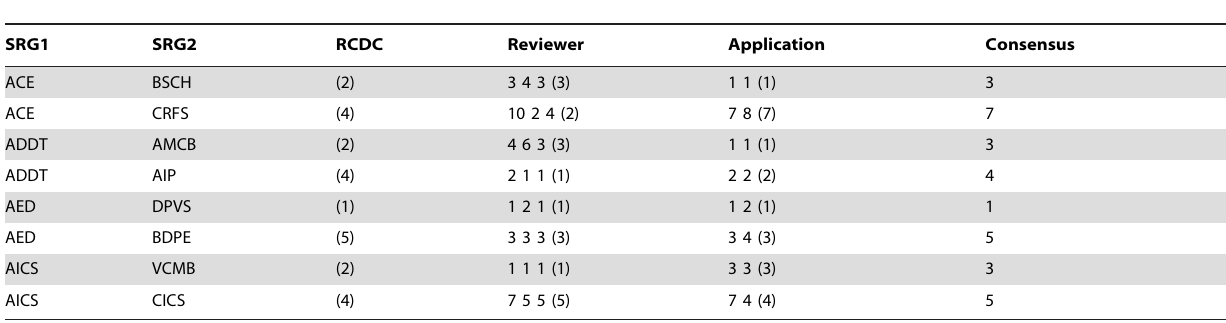
Table 2. Examples of consensus rank calculations.